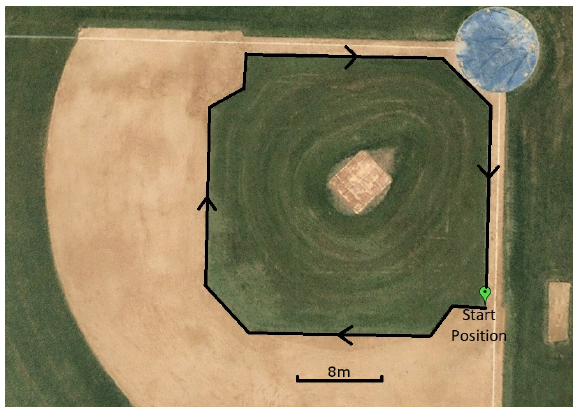
Figure 5. Map for mobile